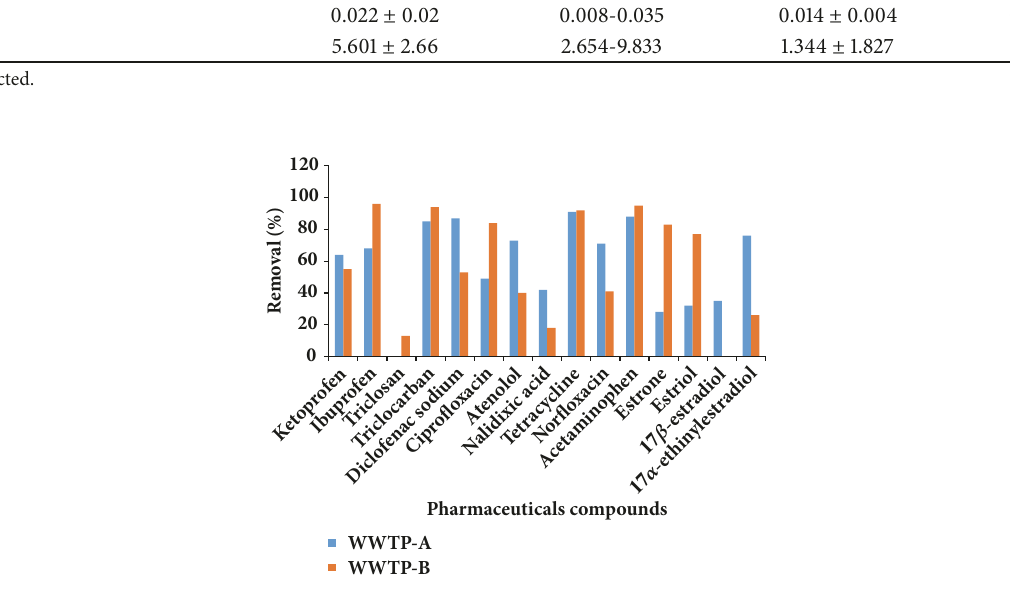
Figure 2: Average removal of pharmaceuticals in both